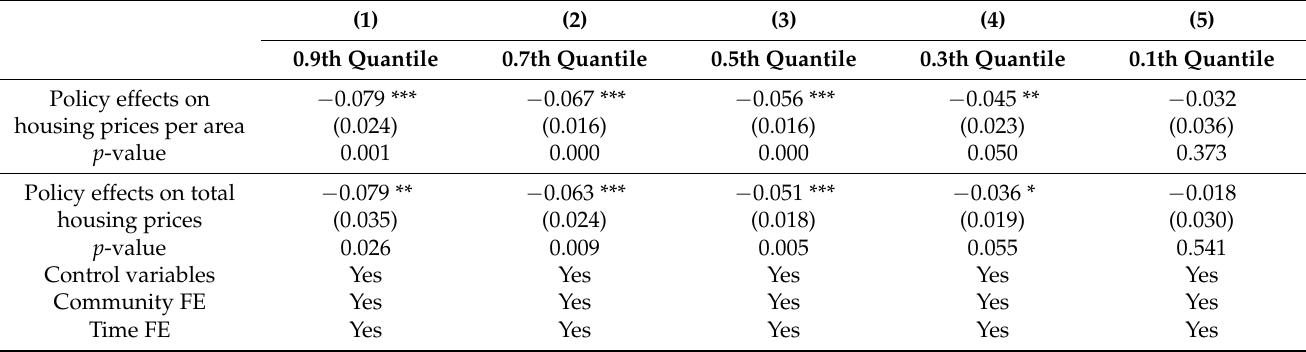
Table 6. Heterogeneous effect of the FJHP on housing prices in the FJHP school